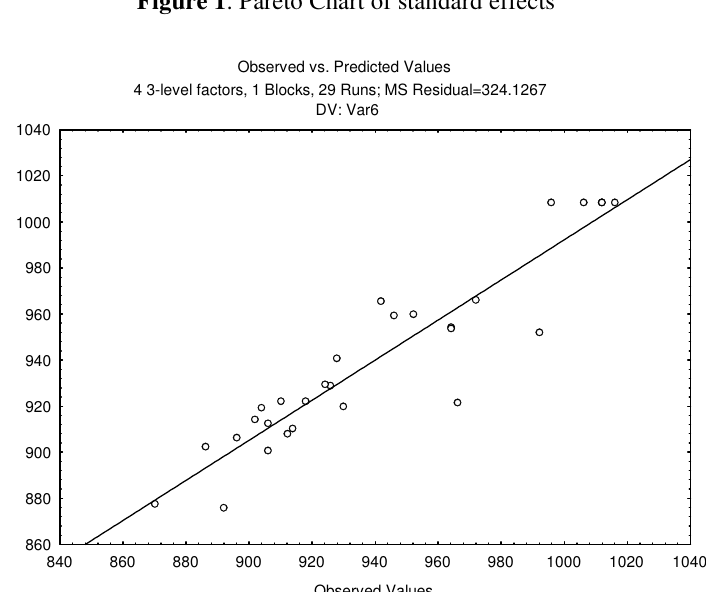
Figure 1 . Pareto Chart of standard effects